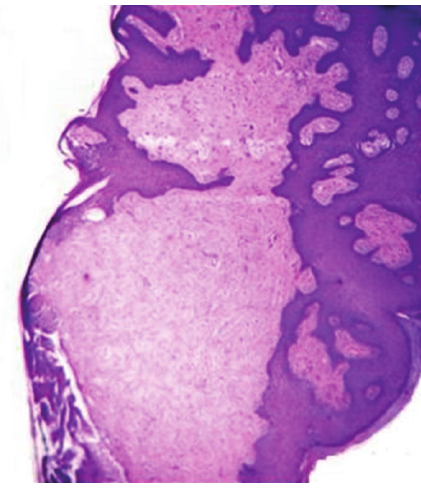
Figure 1: Photomicrograph showing a fibrous mass with overlying stratified squamous epithelium with elongated rete ridges. (Hema- toxylin and Eosin, original magnification 4x).